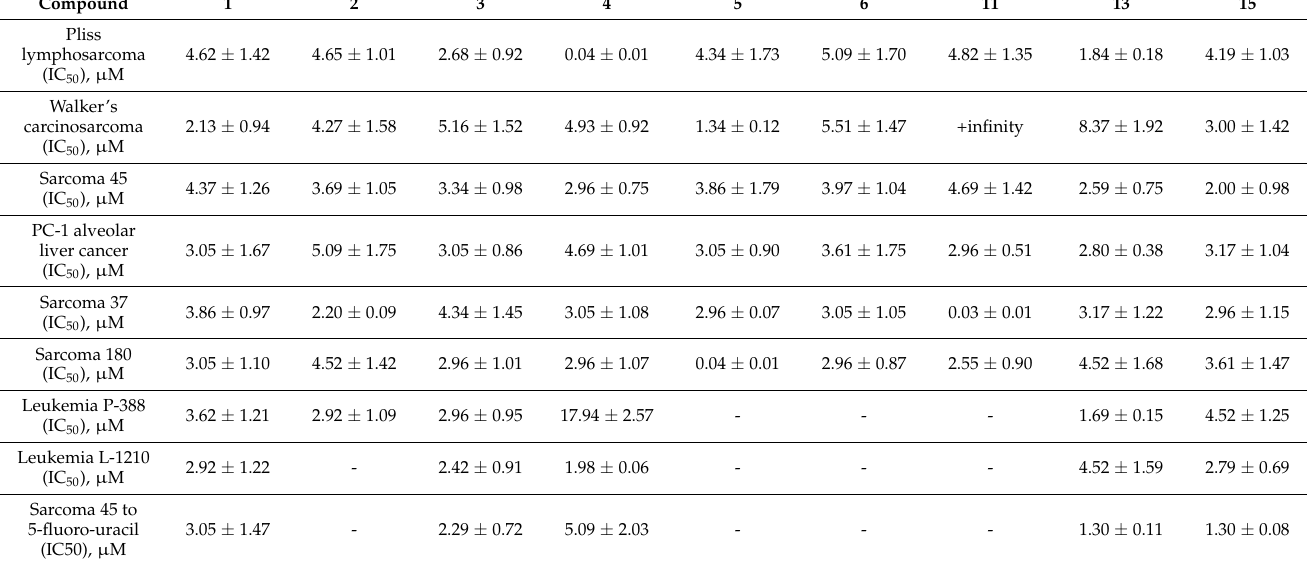
Table 6. IC 50 antitumor activity of estafiatin 1 and its